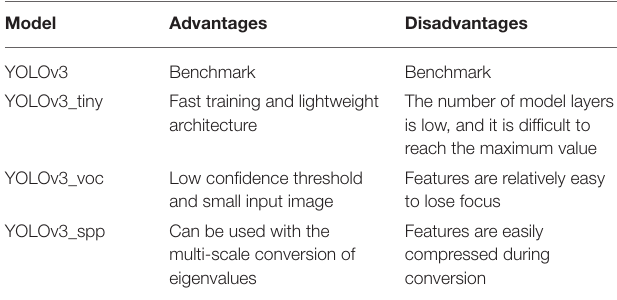
TABLE 1 | Comparison table based on YOLO